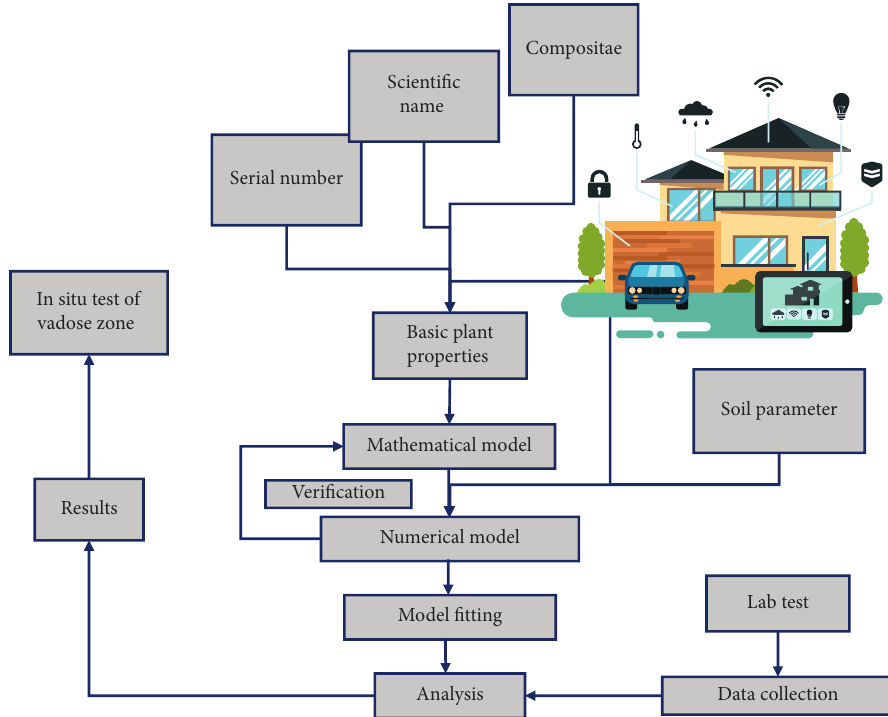
Figure 3: Changes in rainfall and runoff.